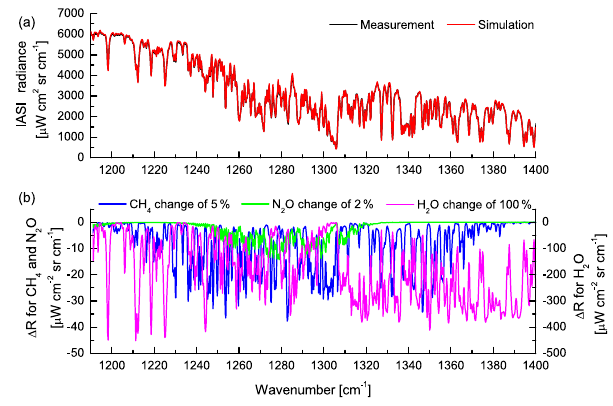
Figure 1. (a) Example of spectral radiances recorded by IASI and the corresponding PROFFIT-nadir simulation over a tropical ocean pixel ( ≈ 12 ◦ S) in winter. (b) Spectral changes in the IASI radiance ( (cid:49) R) due to a change in CH 4 of 5%, in N 2 O of 2% and in H 2 O of 100% (please note the different y -axis scale for H 2